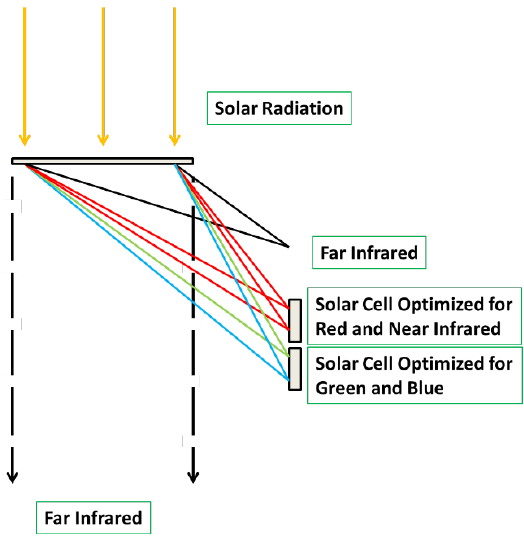
Figure 2. Holographic solar concentrator with spectral splitting systems [5,50].